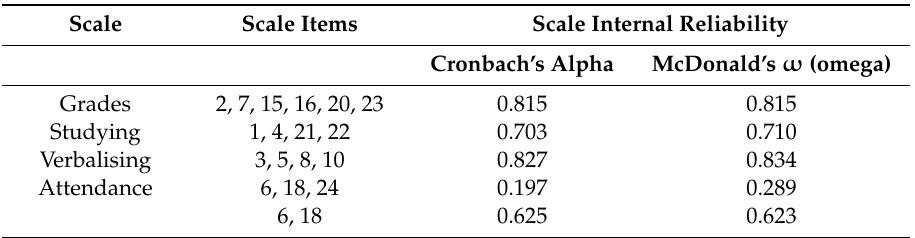
Table 2. Internal reliability of the 4 factors of the Academic Behavioural Confidence scale.